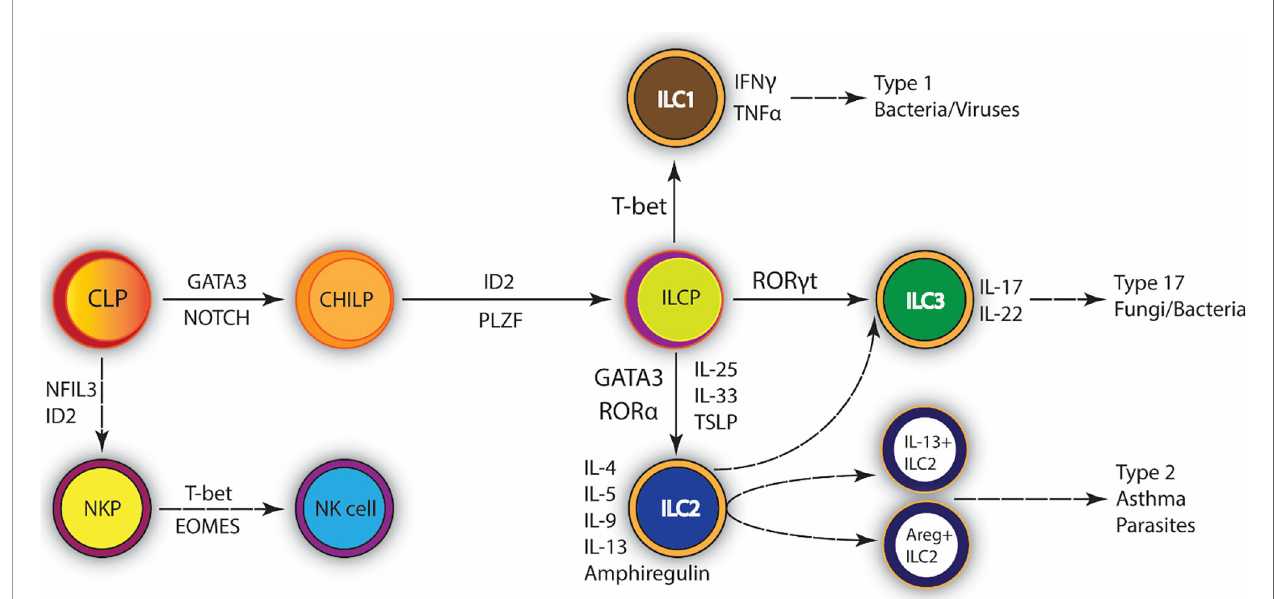
FIGURE 1 | Development of Type 2 Innate lymphoid cells (ILC2). ILC2 promote type 2 in fl ammation and tissue repair. They are mainly involved in the immune response against extracellular parasites. Common lymphocyte progenitor differentiates into ILC progenitor. GATA-3 is the central transcription factor required for their maintenance and survival. ILC2 are activated by IL-25, IL-33, and TSLP; upon infection they secrete IL-4, IL-5, IL-9, IL-13 and Amphiregulin (Areg). Exaggerated ILC2 immune responses can lead to the development of asthma. CLP, Common lymphoid progenitor; CHILP, Common helper and Innate lymphoid progenitor; ILCP, Innate lymphoid cell progenitor; GATA3, GATA-binding protein 3; ID2, inhibitor of DNA binding 2; NKP, NK precursor; NK, Natural killer cell; PLZF, promyelocytic leukemia zinc fi nger